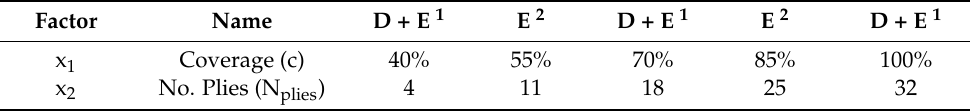
Table 5. Design and evaluation points used in the response surface